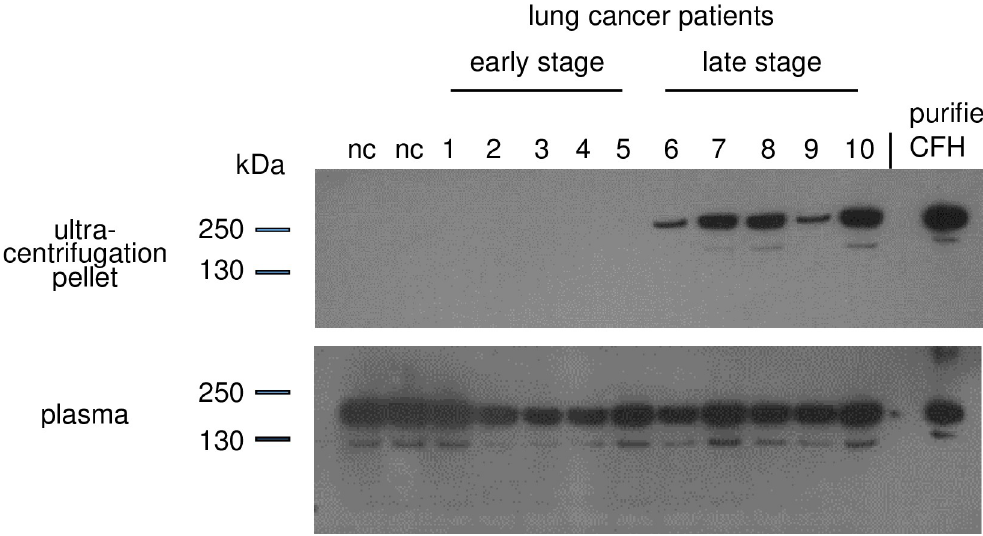
Fig 3. CFH in ultracentrifugation pellet and plasma of lung cancer patients. EVs were isolated from plasma by ultracentrifugation. Equal volumes of ultracentrifugation pellet and original plasma from each patient were subjected to western blot analysis. The blots were each probed with GT103 followed by an anti-mouse IgG-HRP secondary reagent (to prevent background binding of a human secondary reagent to human IgG in the samples). Top blot: The pellet from 5 early stage (1–5) and 5 late stage (6–10) patients. The last lane contains 20 ng purified human CFH (Complement Technology, Inc.) Bottom blot: Plasma from the same patients. The pellet and plasma from two control patients with no cancer (nc) are also included on the blot. Shown are results from a subset of 10 lung cancer patients of a total of 19 analyzed; only one early stage patient had a detectible CFH band in EVs. (See S2 Fig for 9 additional human samples, including the early stage patient with CFH-containing